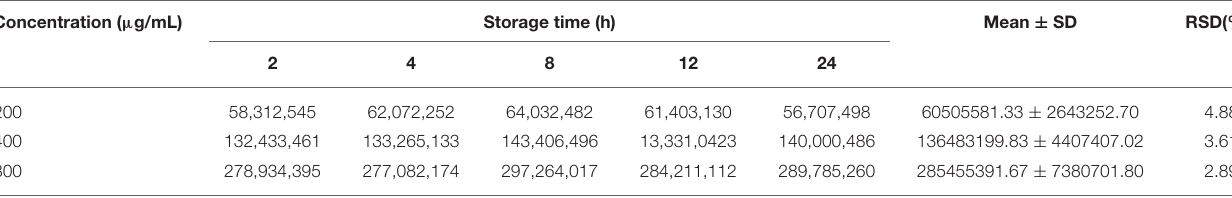
TABLE 3 | Changes in peak area (Au) during storage of squalene solutions. Concentration ( µ g/mL)